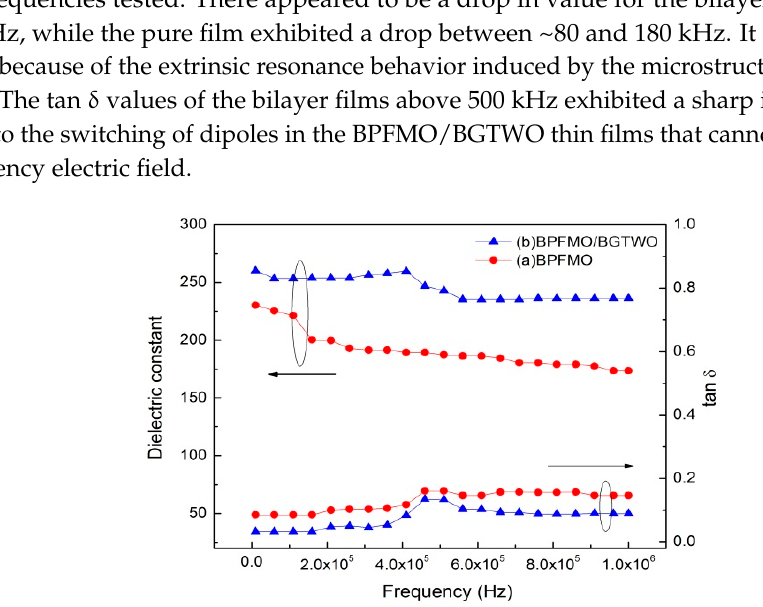
Figure 3. Dielectric constant ( ε r ) and tan δ of ( a ) a pure BPFMO film and ( b ) a BPFMO/BGTWO bilayer thin film.